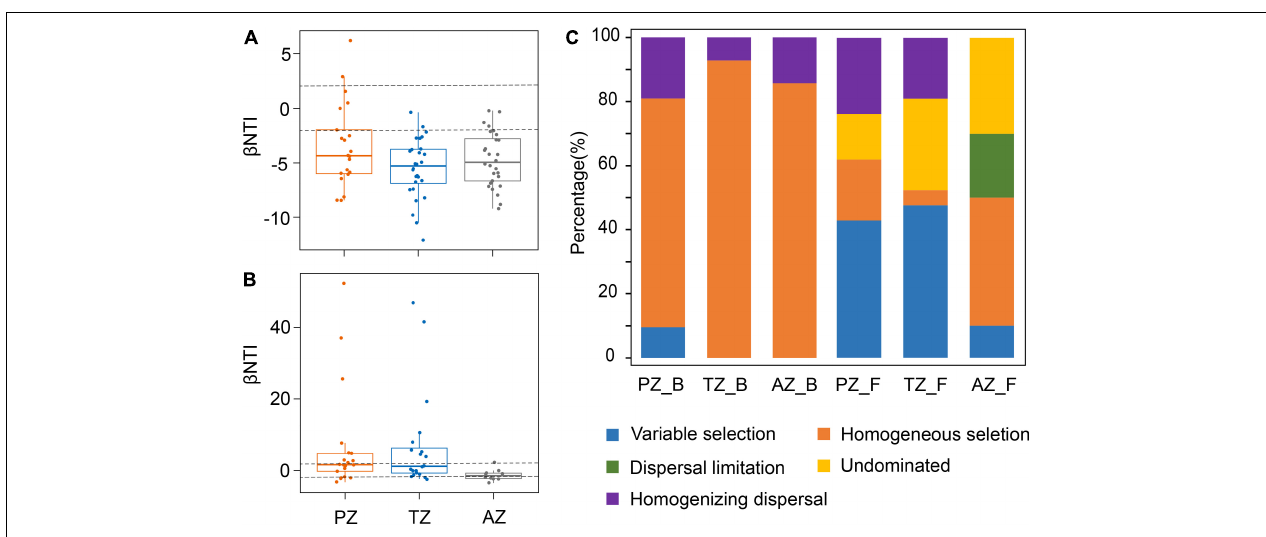
FIGURE 4 | Phylogenetic and null model analyses show the assembly processes of bacterial (A) and fungal communities (B) in the photic zone (PZ), twilight zone (TZ), and aphotic zone (AZ) tested by β NTI values. The contribution of each ecological process to microbial community assembly in different zones in the Heshang Cave (C) . PZ_B, TZ_B, and AZ_B indicate the ecological processes responsible for bacterial community assembly in the photic zone, twilight zone, and aphotic zone, respectively, whereas those PZ_F, TZ_F, and AZ_F denote fungal community assembly.